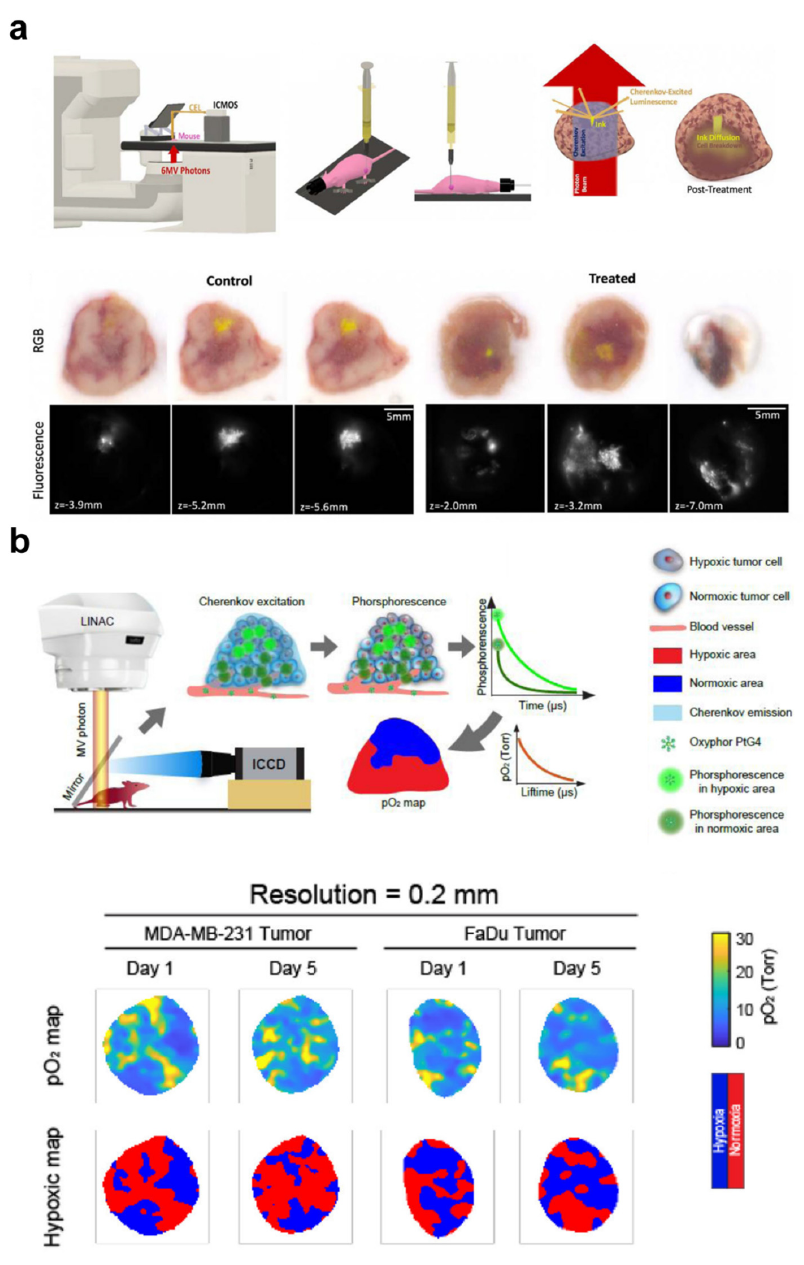
Figure 6. Tumor microenvironment monitoring with Cherenkov luminescence image. ( a ) Top: Workflow diagram of tracking tumor radiotherapy response in vivo with Cherenkov excited luminescence ink imaging. Bottom: Examples of the results. Adapted with permission from Ref. [61] 2020 IPO Publishing. Ltd. ( b ) Top: Workflow diagram of in vivo pO2 imaging based on Cherenkov excited luminescence imaging. Bottom: Examples of the results. Adapted with permission from Ref. [35] 2021 Elsevier.